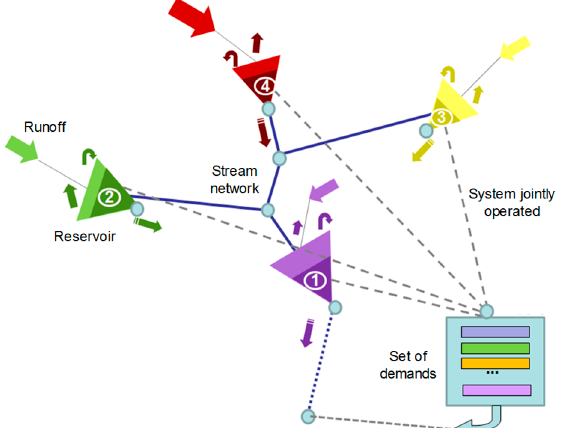
Figure 2. Operation scheme of the high-resolution Water Availability and Adaptation Policy Assessment (WAAPA) model for each given point of the stream network (blue lines). Triangles represent dams, big coloured arrows represent inflows, small arrows represent reservoir evaporation, uncontrolled spills, and environmental flows, and grey dashed lines represent supplies from each reservoir to the basin demands (rectangles).